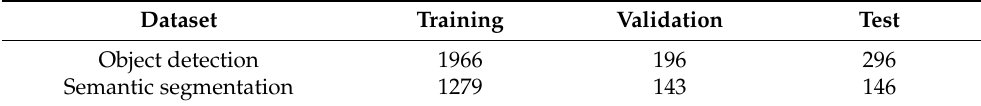
Table 1. The dataset for object detection and semantic segmentation.